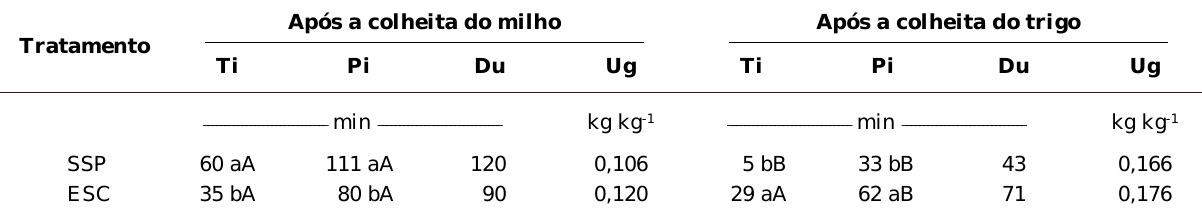
Quadro 2. Valores médios dos tempos de início (Ti) e pico (Pi) do escoamento superficial, da duração das chuvas (Du) e da umidade gravimétrica antecedente do solo (Ug), após as colheitas do milho e do trigo, em dois tratamentos de preparo do